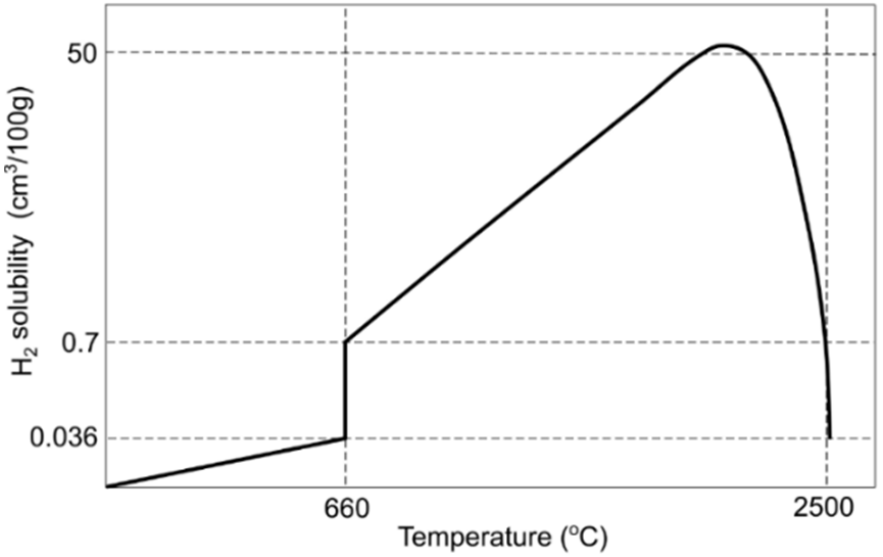
Figure 4. Hydrogen solubility in Al during welding thermal cycle at 1 atm pressure. Adapted and redrawn from [18,31–33].